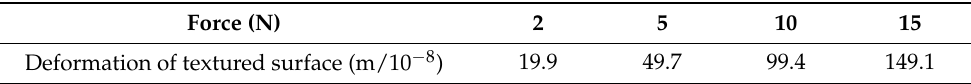
Table 2. The result of the stress of the textured surface and smooth surface. Force (N) 2 Figure 10. The result of ( a ) the deformation and ( b ) stress of textured surface under the load of 15 N. Equivalent stress of textured surface (MPa) Stress of smooth surface